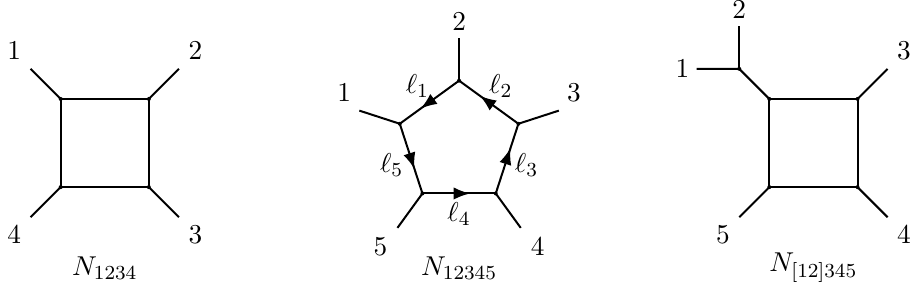
Figure 1. Box and pentagon numerators at four and five points. Here and below, we label the loop momenta in a diagram only when the corresponding numerator depends on